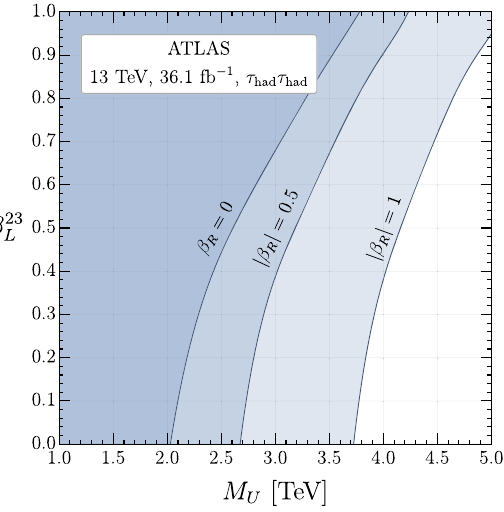
= 0 and, for comparison, we also show the limits from plot we set β 23 L U 1 pair production. In the right plot we set g U = 3 . R